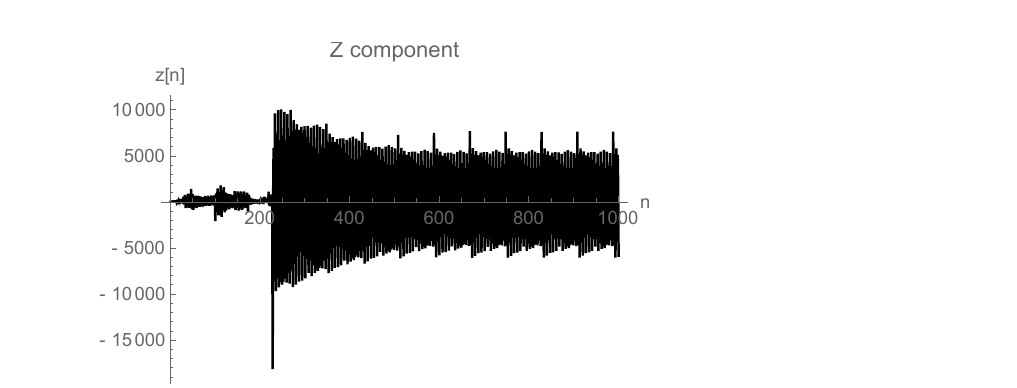
Figure 10. Graph of z n for α = 2.5, β = 0.05, γ = 0.7, δ = 0.6, ζ = 3.5, η = 0.05, µ = 0.01, ε = 4.1, υ = 0.09, ρ = 0.02, σ = 0.04, ω = 0.06. with initial conditions x 0 = 0.1, y 0 = 0.02 and z 0 = 0.04.